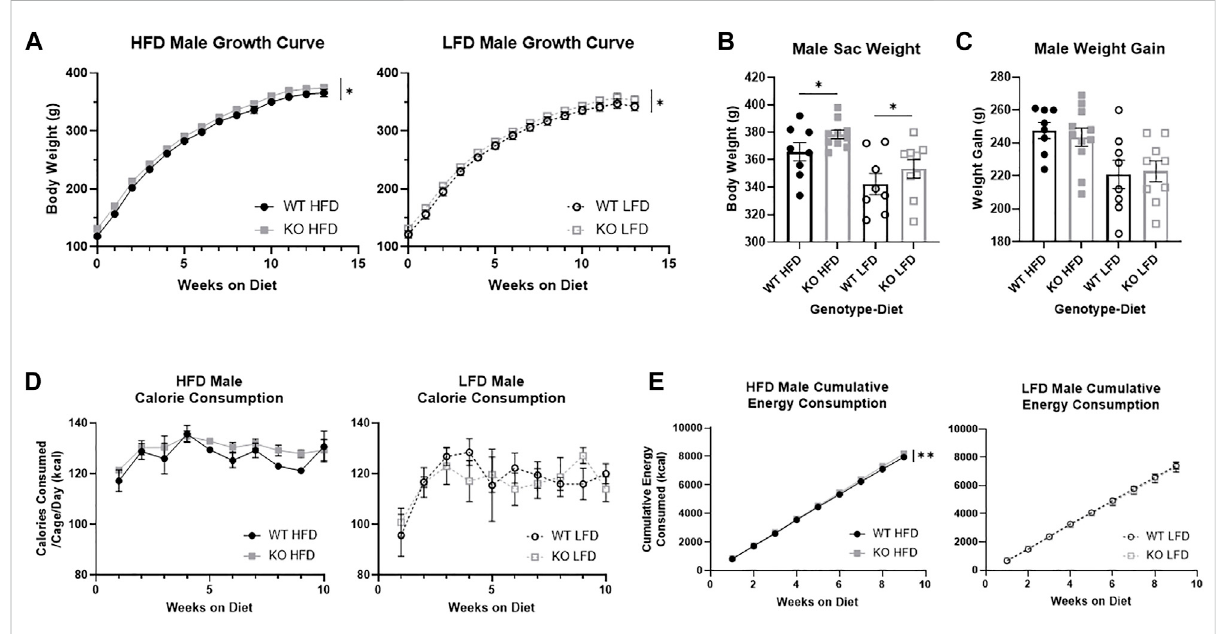
FIGURE 3 Body weight growth and energy consumption in male wild-type (WT; black circle) and Krtcap3 knock-out (KO; gray square) rats. Rats were weighed weekly throughout the study, and fi nal weight and overall weight gain were recorded. Calorie consumption was recorded for the fi rst 10 weeks on diet, and cumulative energy consumption calculated for the fi rst 9 weeks on diet. To highlight genotype-driven differences, fi gures are separatedbydiet,high-fatdiet(HFD; fi lled)andlow-fatdiet(LFD;empty). (A) KOmaleswereconsistentlyheavierthanWTmales(circle)onboth diets. Signi fi cance * p < 0.05 represents a main effect of genotype over time across both diets. (B) At euthanasia, KO males were heavier than WT males, where * p < 0.05 shows a main effect of genotype across both diets. (C) However, there were no differences in weight gain between WT and KO males. (D) There were no differences by genotype in caloric intake, yet. (E) KO HFD males had a greater rate of caloric intake than WT HFD males while there were no differences by genotype in LFD males. ** p < 0.01 represents a signi fi cant difference in the slopes of the lines. Diet effects are reported in the “ Results ”